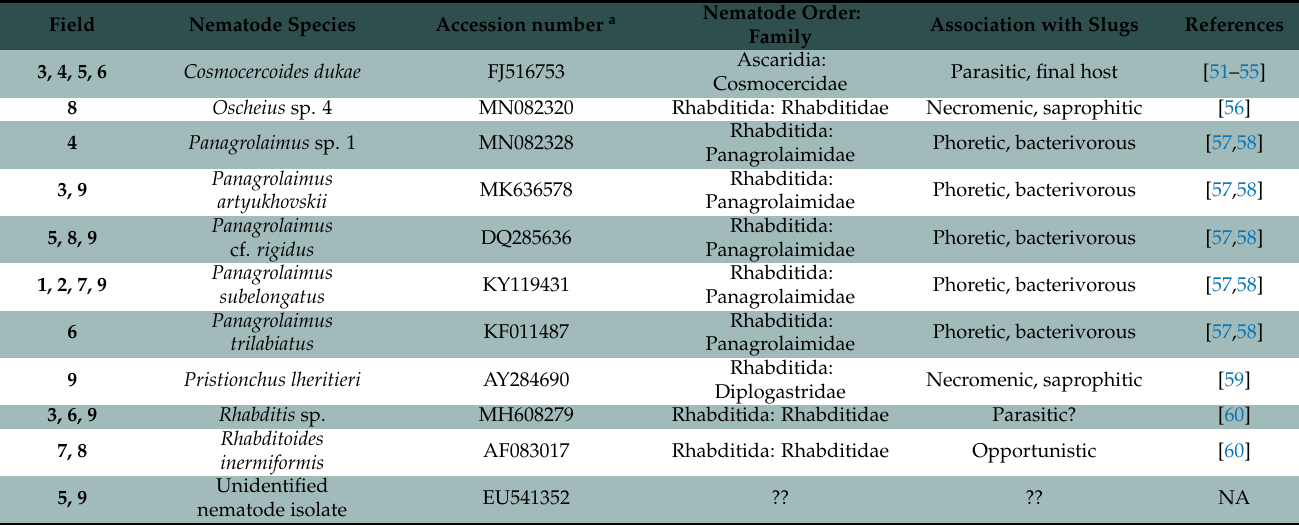
Table 2. Nematodes associated with dead slugs trapped in soybean